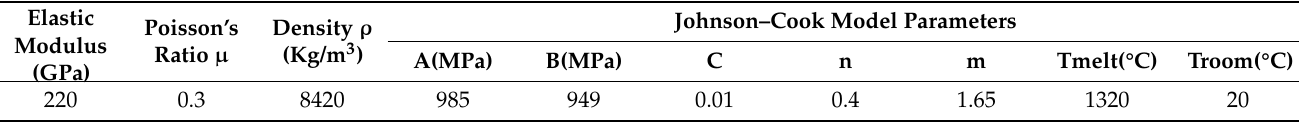
Table 2. Material properties of